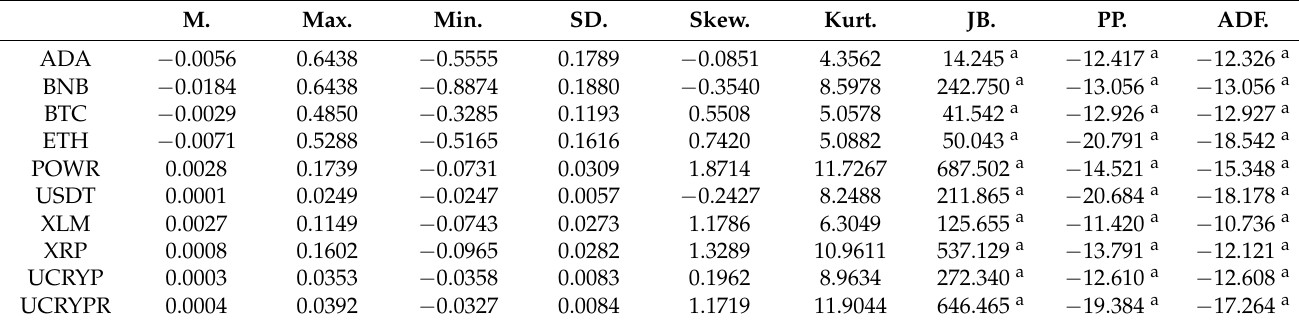
Table 1. Summary statistics.